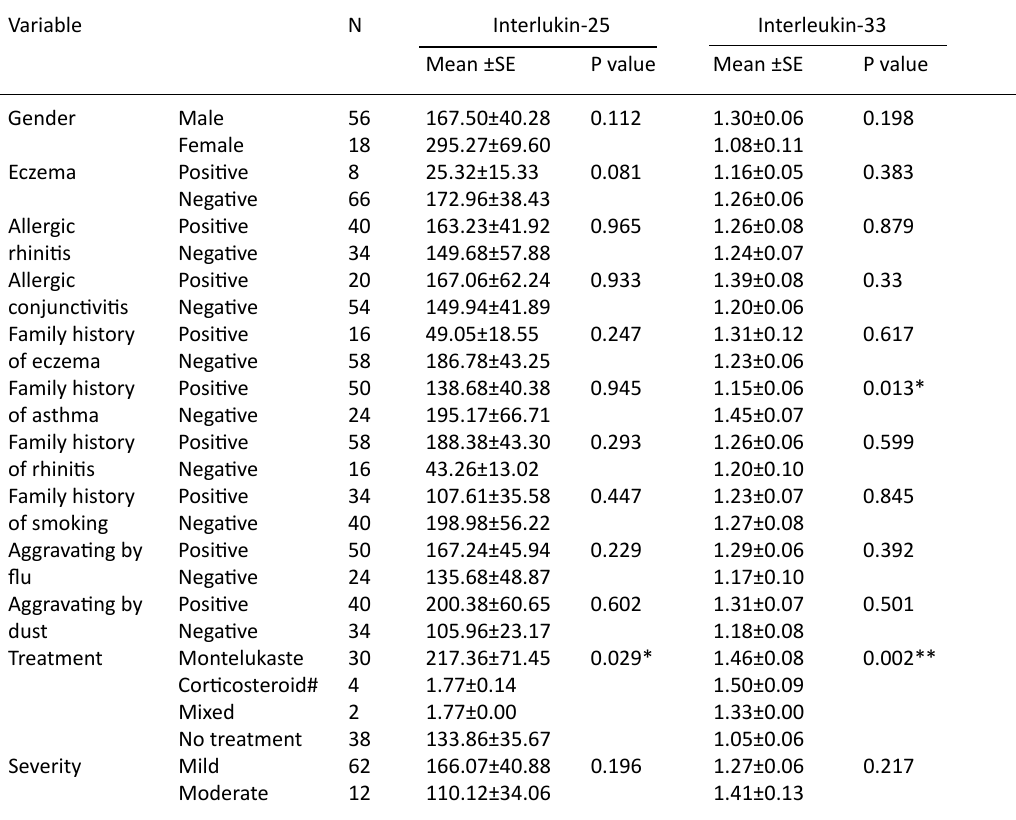
Table 1. Differences in the concentration of IL-25 and IL-33 according to different sociodemographic and clinical variables among asthmatic